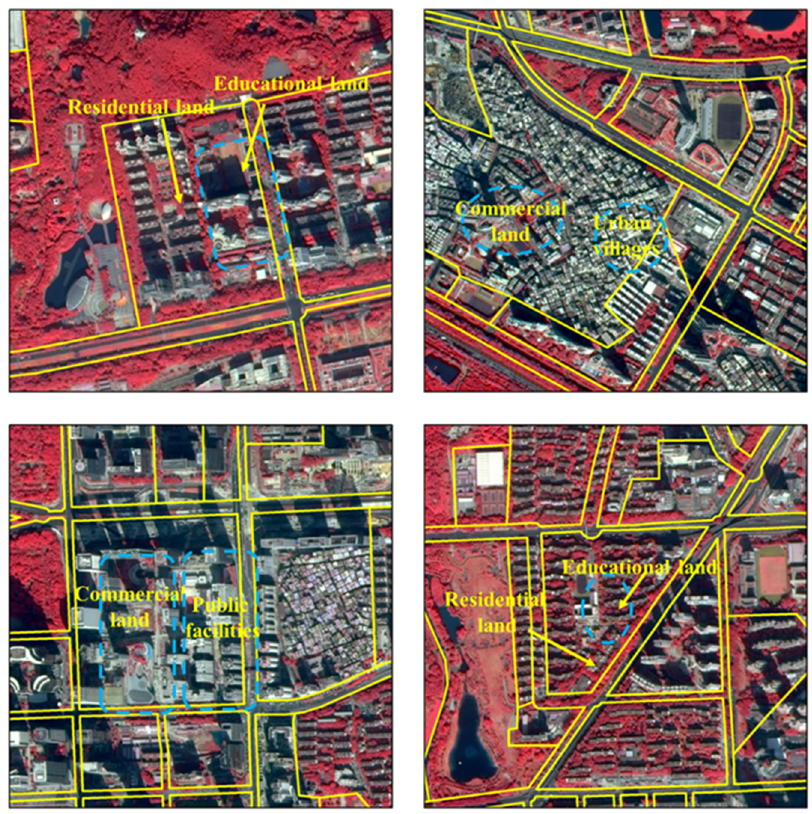
Figure 1. Illustration of traffic analysis zone (TAZs) with mixed land use types.